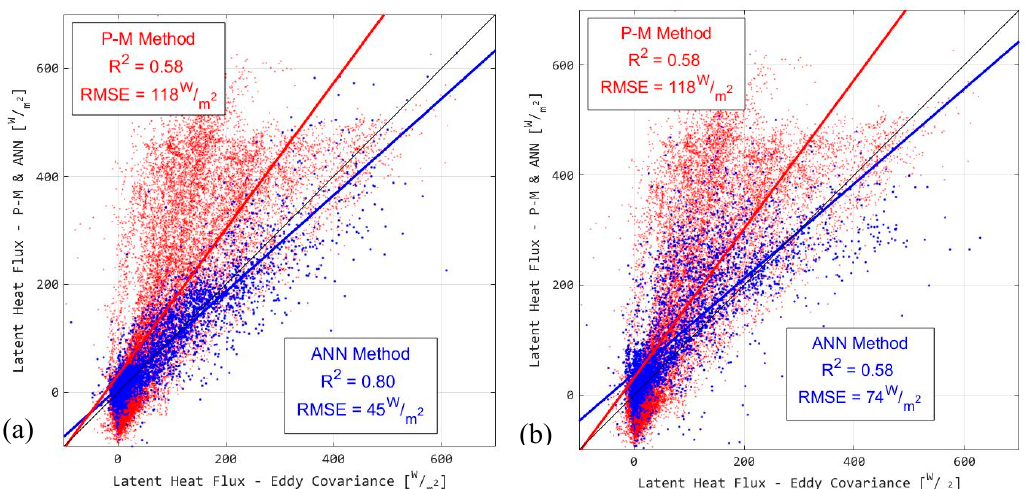
Figure 5. Method comparisons at site 1 from 7 day training ( a ) mid-season, when the crop was adequately irrigated; and ( b ) at the end of season, when irrigation was over-applied.